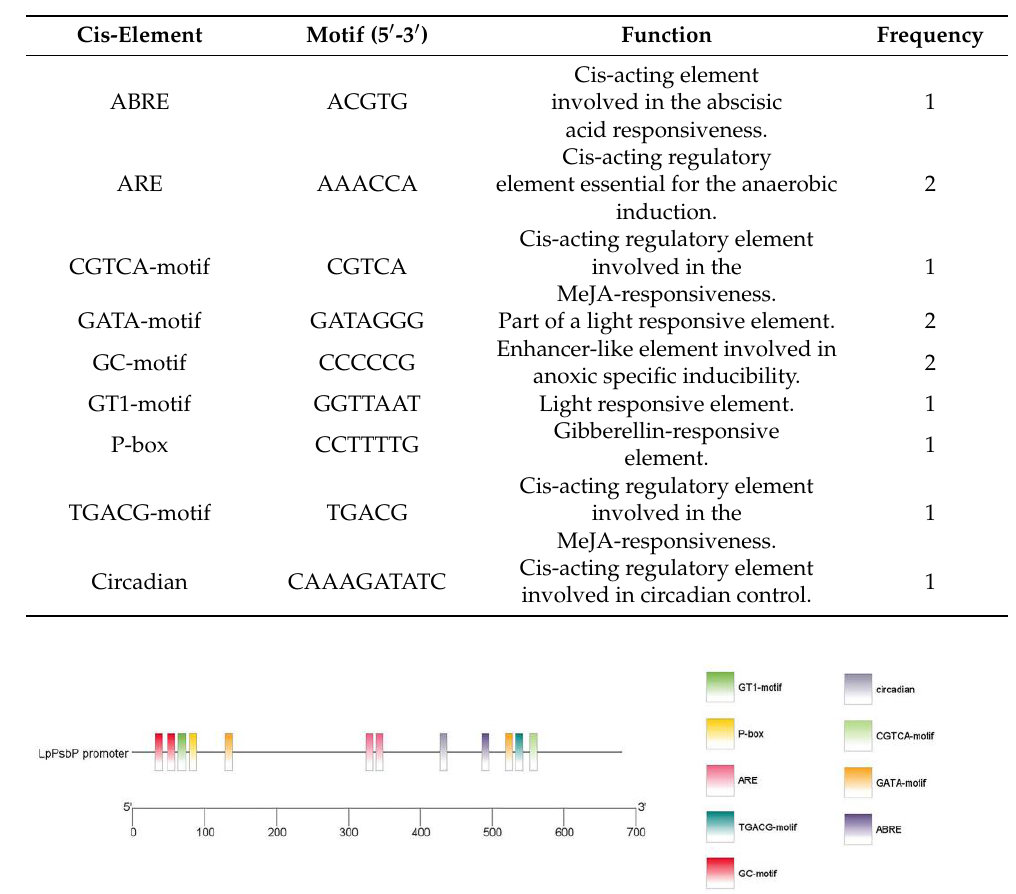
Table 3. Analysis of cis-acting elements in the promoter sequence of LpPsbP gene.